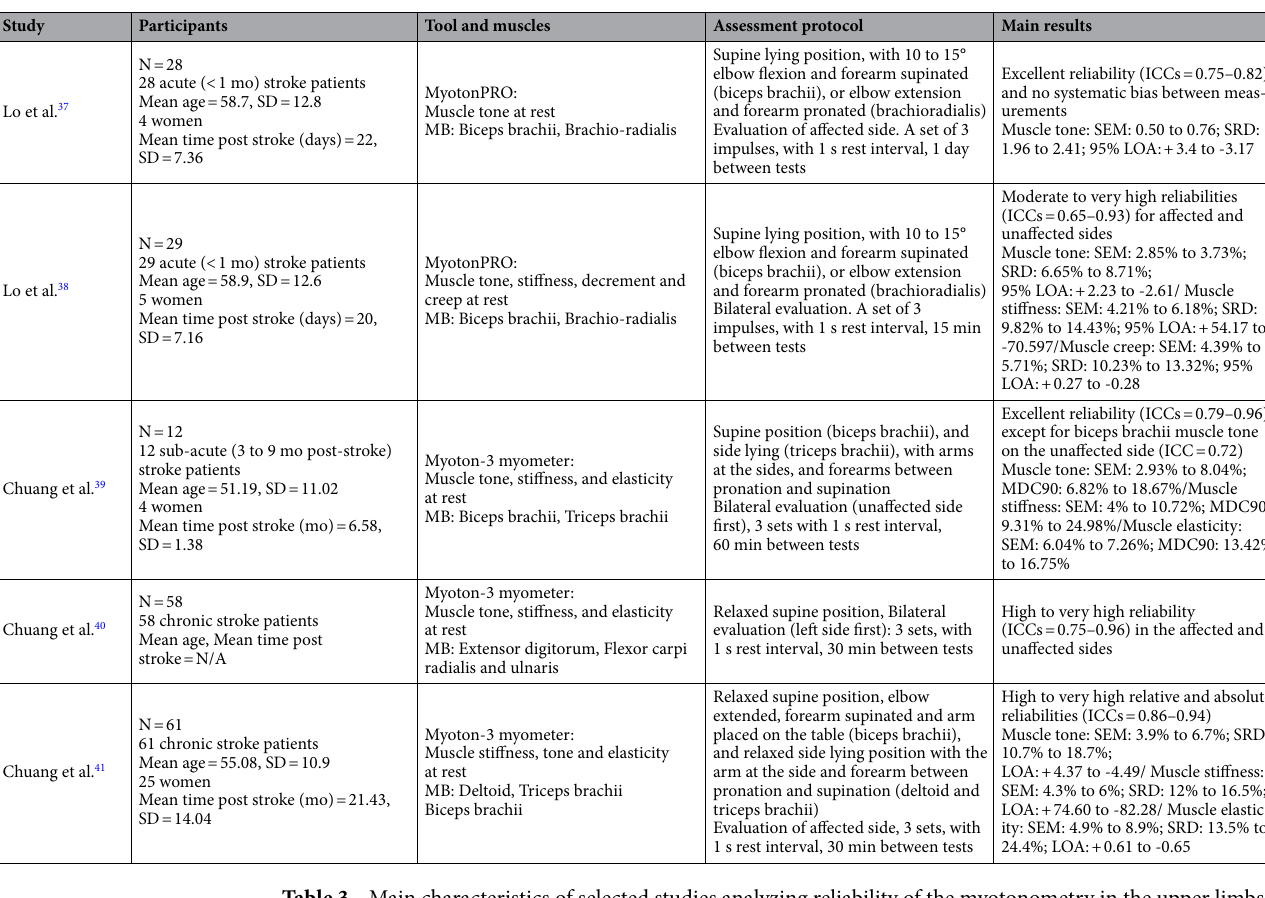
Table 3. Main characteristics of selected studies analyzing reliability of the myotonometry in the upper limbs. N/A: non available; MB: muscle belly; MDC: minimal detectable change; mo: months; SRD: smallest real